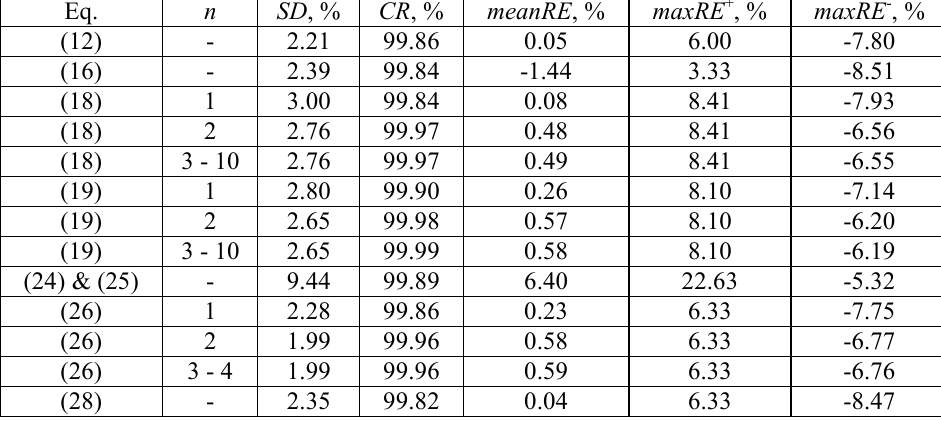
Table 4 Review of the correlations for turbulent transition pipe flow (database z = 412)